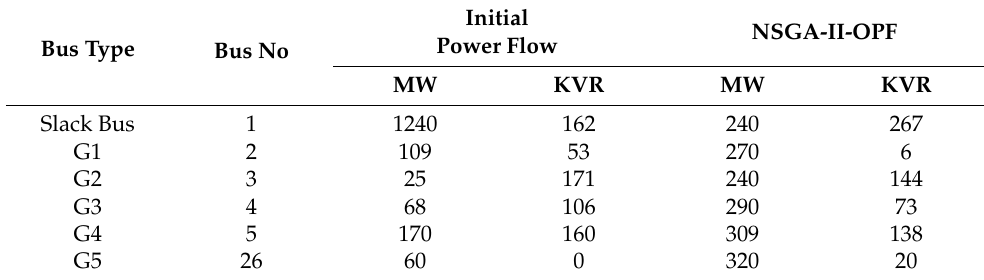
Table 2. Compression power flow